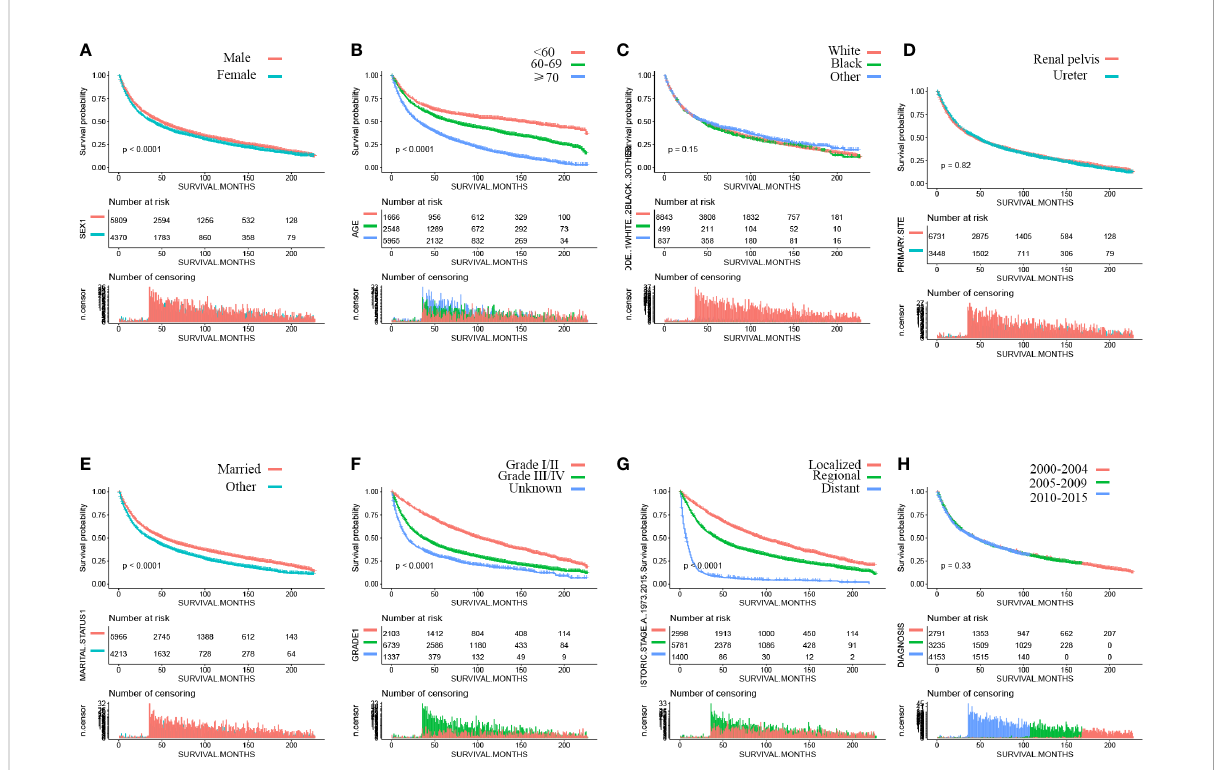
FIGURE 2 Kaplan – Meier curves of overall survival of patients by (A) sex, (B) age, (C) race, (D) primary site, (E) marital status, (F) grade, (G) stage, and (H) year of diagnosis.